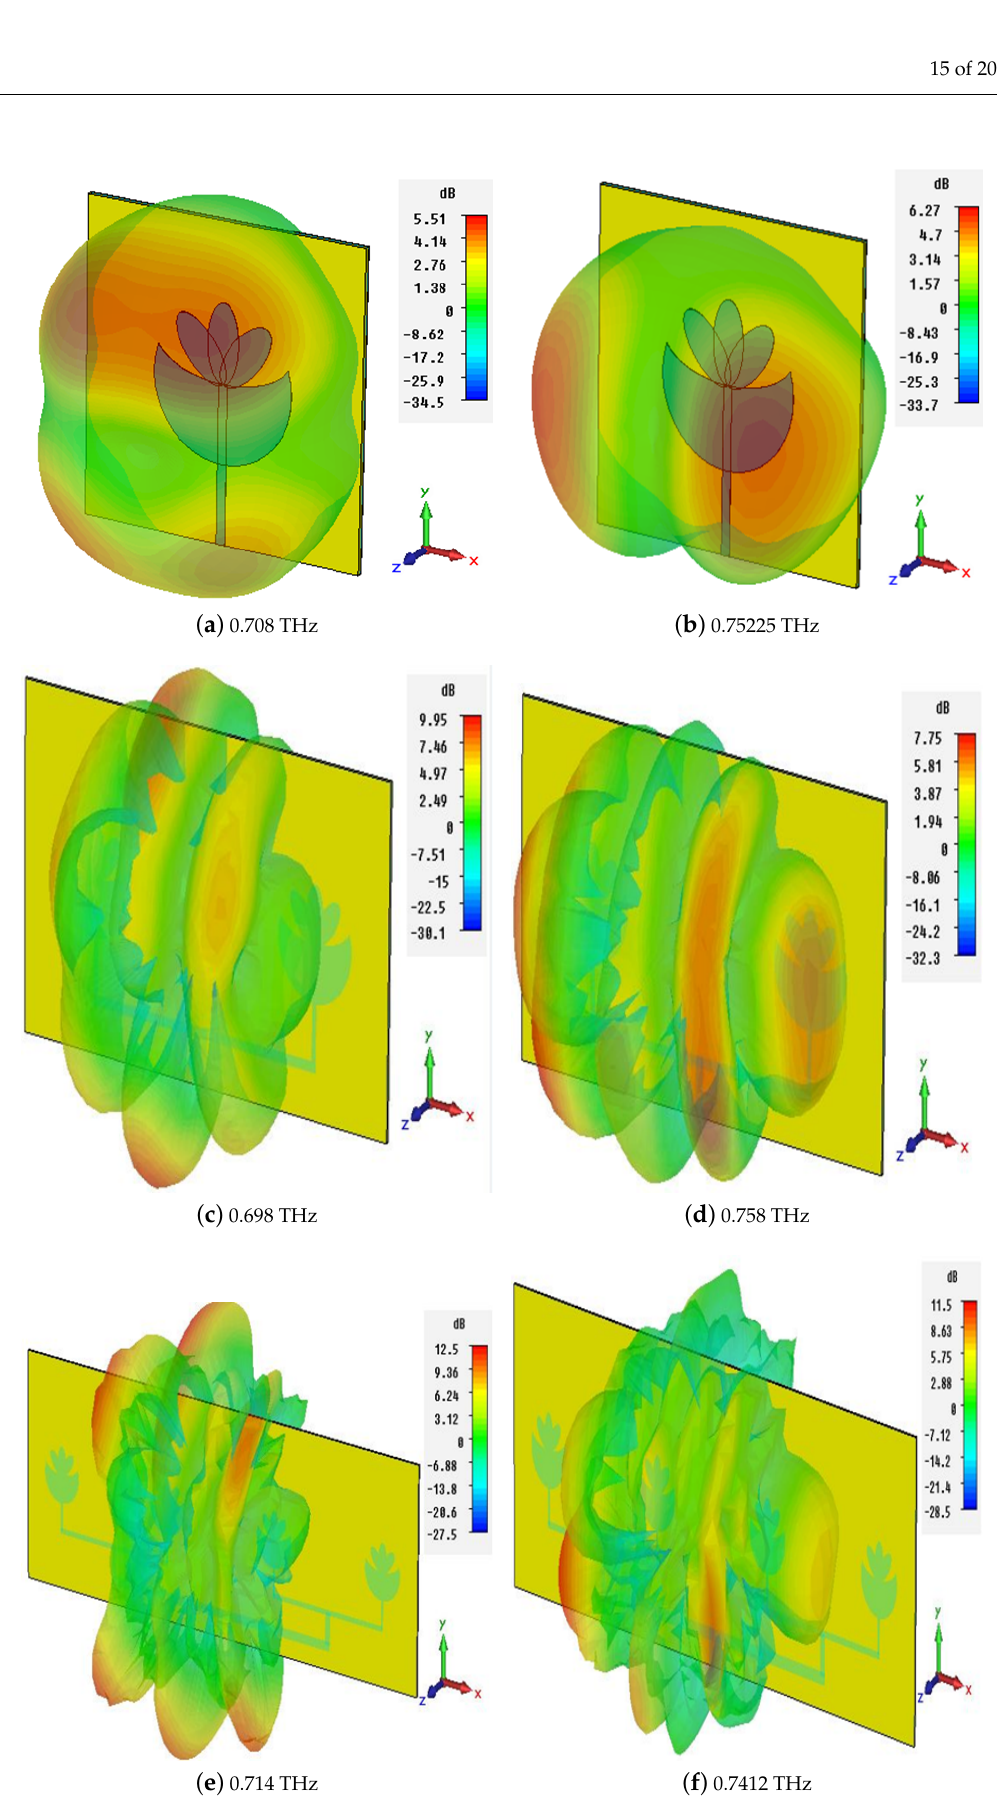
Figure 14. Far field radiation pattern: ( a ) Type A at 0.708 THz, ( b ) Type A at 0.75225 THz, ( c ) Type B at 0.698 THz, ( d ) Type B at 0.758 THz, ( e ) Type C at 0.714 THz, and ( f ) Type C at 0.7412